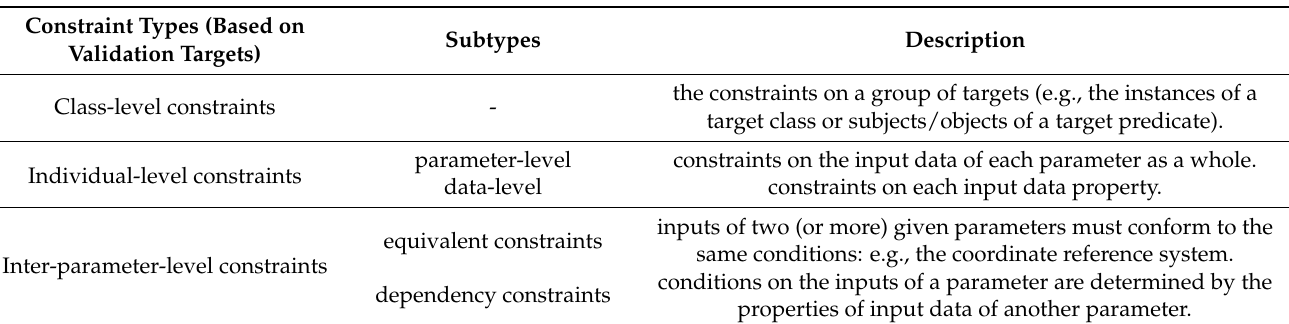
Table 2. Classification of parameter constraints of geoprocessing tools according to their validation targets. Constraint Types (Based